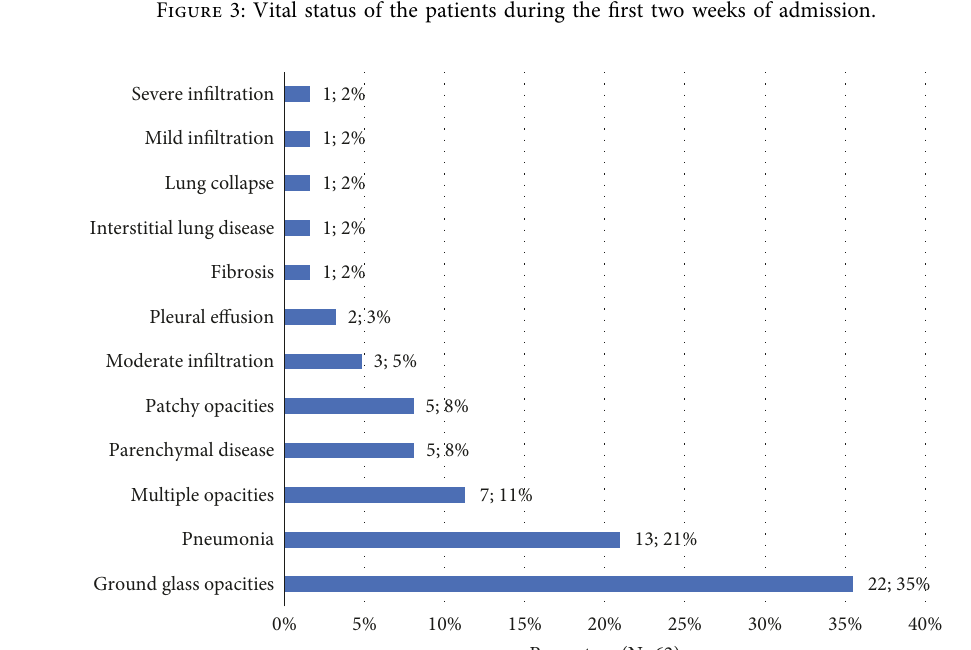
Figure 3: Vital status of the patients during the first two weeks of admission.